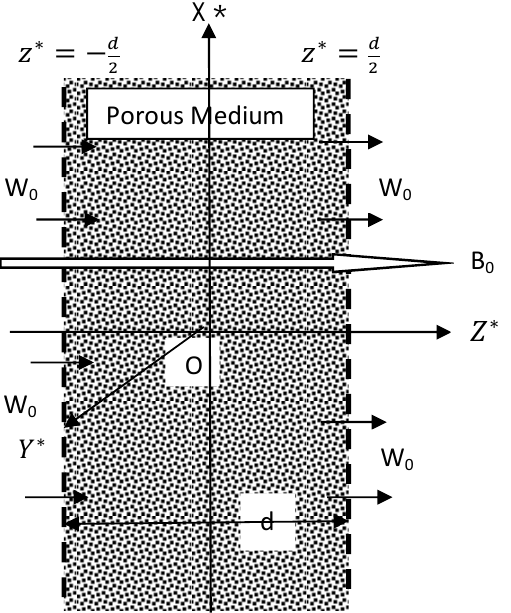
Fig. 1. Physical configuration of the